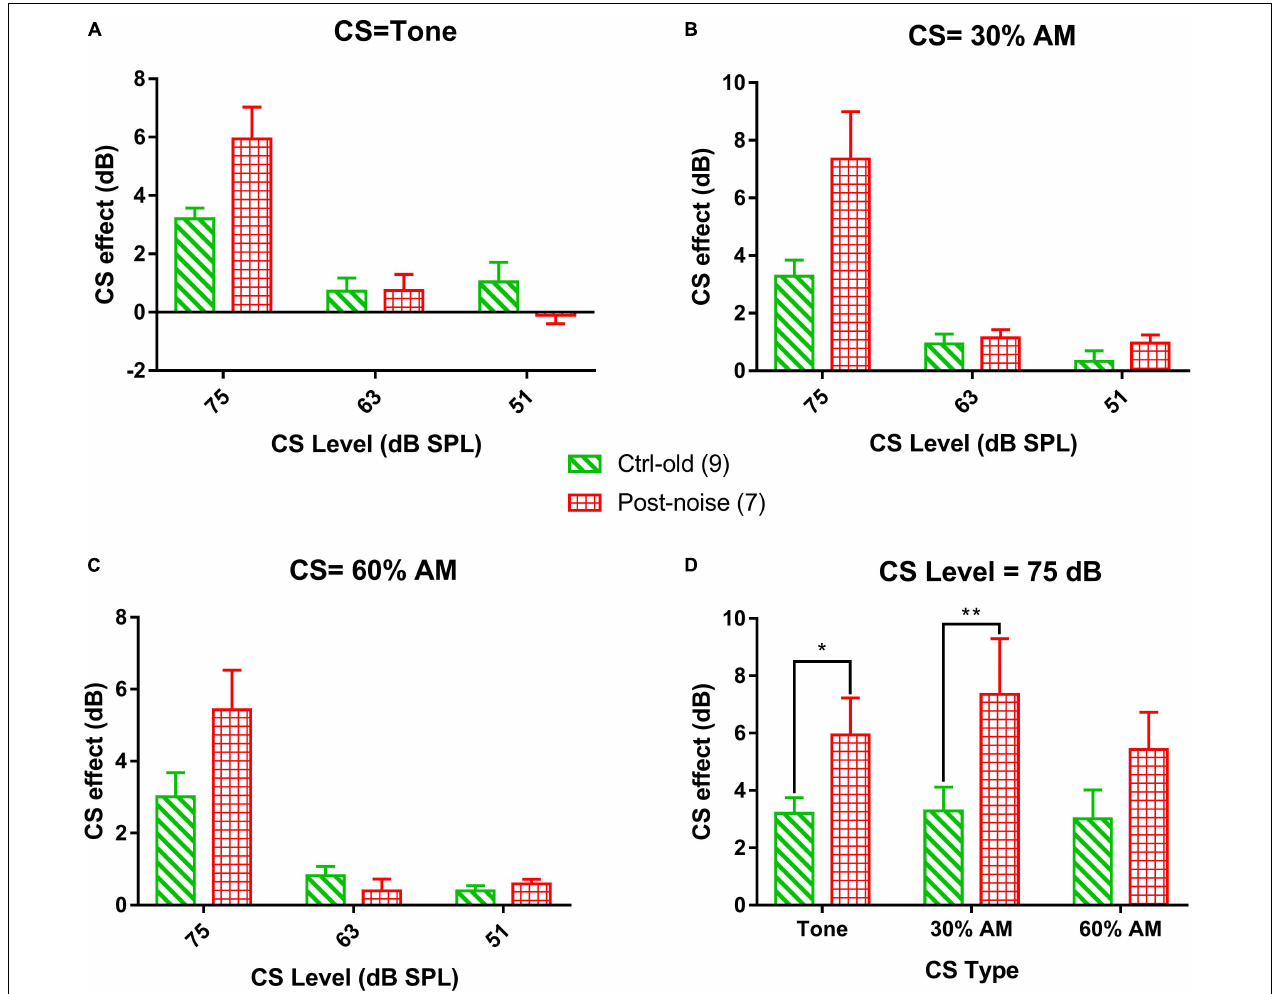
FIGURE 8 | The CS effect on transient CAP in response to 16 kHz. tone bursts at the low-level average (the average of the stimulation levels of 20, 25, and 30 dB SPL). The CS signals are 16 kHz tone bursts, and AM with 30% and 60% modulation, respectively, across three levels (75-, 63- and 51-dB SPL). (A–C) The effect of CS level on the CAP across groups, showing a decreased CS effect with decreasing CS level, consistent across the three types of CS signals. (D) Comparison of CS effect across CS type and group with 75 dB SPL CS